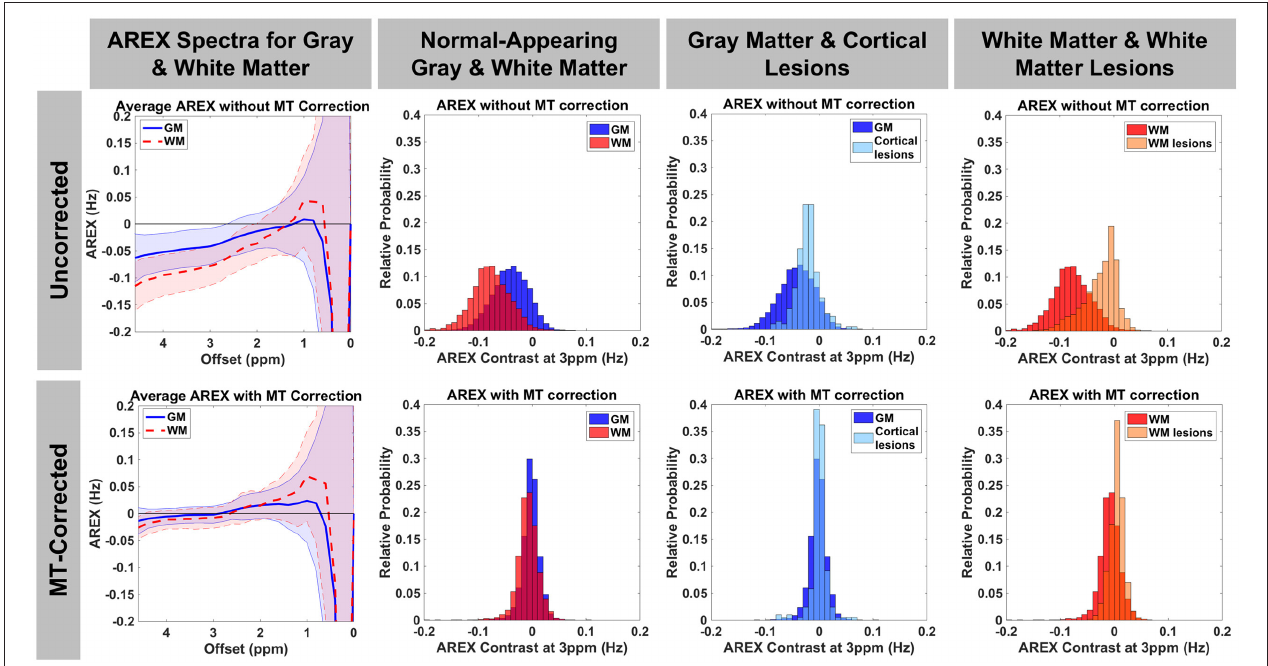
FIGURE 4 | AREX spectra and histograms for AREX contrast at 1 ω = 3.0 ppm are shown without (top row) and with (bottom row) MT baseline removal for a representative patient with MS (46-year-old male, EDSS = 4, duration = 16 years). Before removing the MT contribution, there is a greater difference between GM and WM and the majority of the AREX values are negative. After removal of the asymmetric MT effect, AREX contrast shifts more toward positive values and the difference between GM and WM is reduced, but slightly higher AREX in GM remains as expected. After correction for MT effects, AREX in cortical lesions overlaps with that in GM, but WM lesions still show a slight increase in AREX relative to